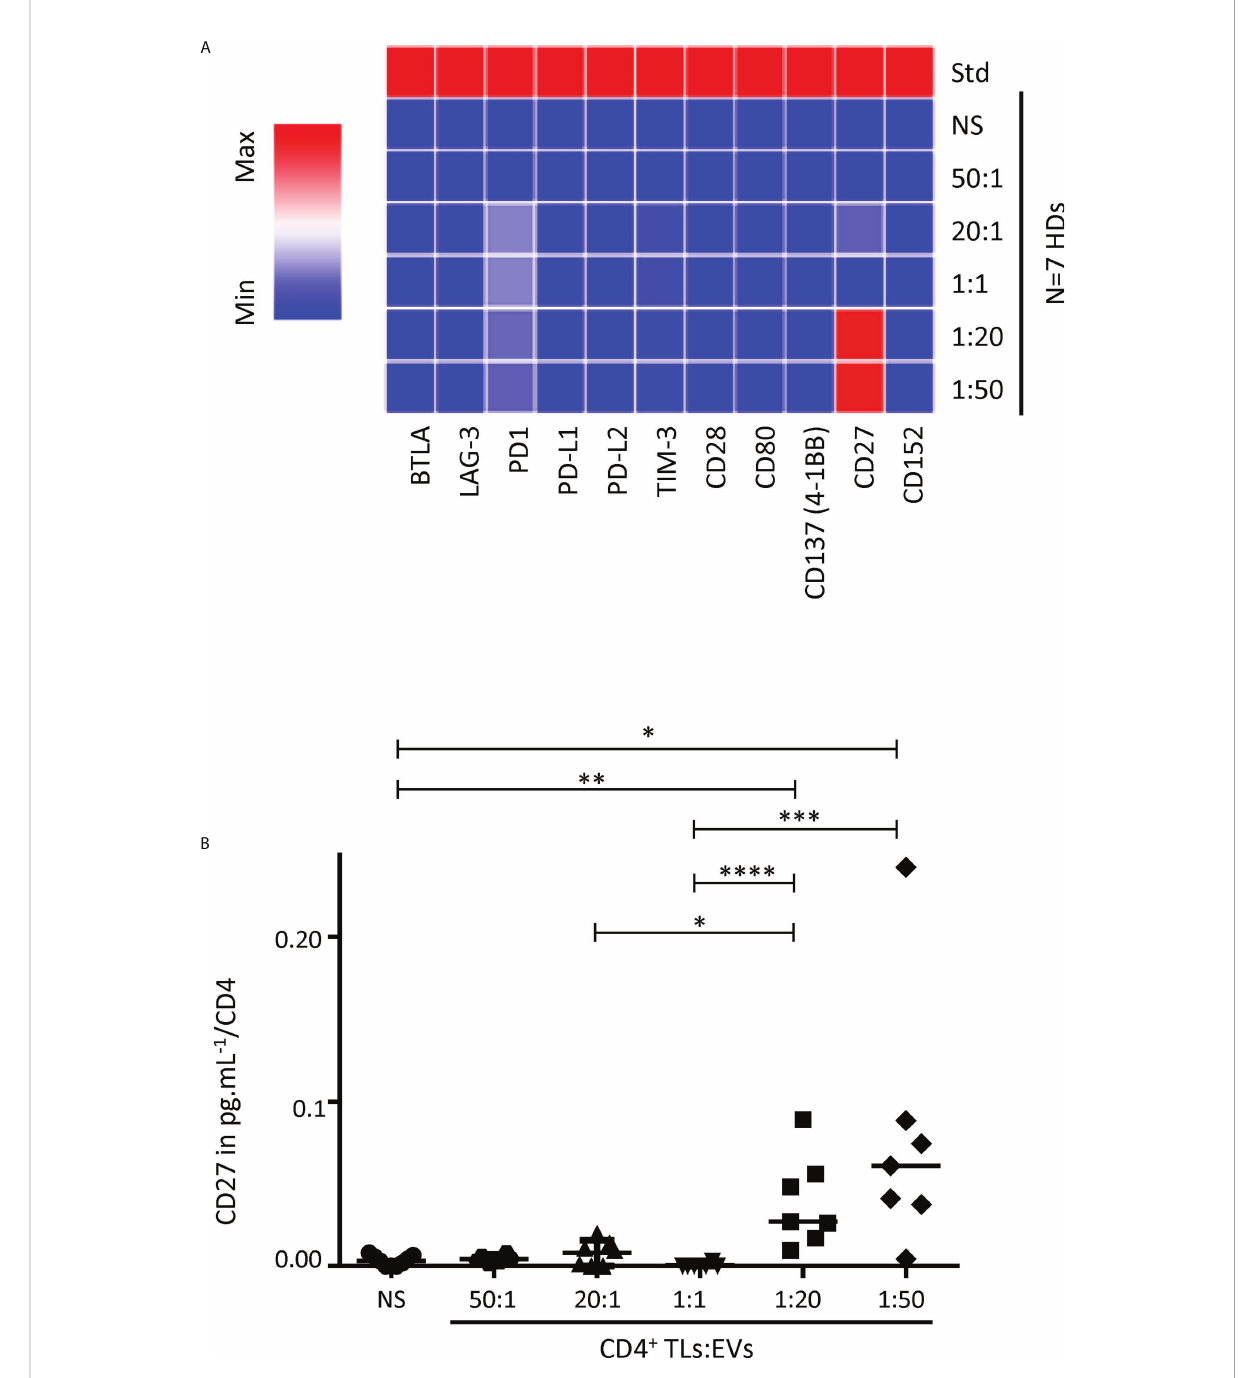
FIGURE 2 Analysis of soluble immune checkpoint levels in the supernatant of cultures of sorted CD4 + TLs and autologous EVs. (A) The levels of 11 soluble immune checkpoints were determined with Luminex technology. A heatmap was generated to compare soluble immune checkpoint concentrations between culture supernatants from CD4 + TLs without EVs (NS) or treated with total autologous EVs at different ratios (CD4: EVs). (B) sCD27 levels in supernatants collected after six days of CD4: EV culture, assessed in pg/mL per CD4 + TL for incubation without EVs (NS, ○ ), or treatment with EVs at different ratios (CD4: EVs): 50:1 ( ○ ), 20:1 ( ▴ ), 1:1 ( ▾ ), 1:20 ( ▪ ) and 1:50 ( ♦ ) for six days (from 7 HDs). Std indicates the standard values for the soluble immune checkpoint. Horizontal bars indicate the median. p values for comparisons were obtained in Kruskal-Wallis tests and Dunn post-hoc tests: * p <0.05, ** p <0.01, *** p <0.001, **** p